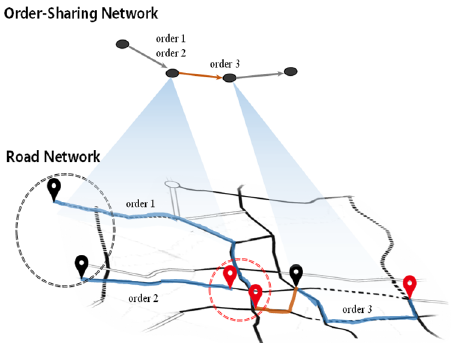
Figure 6. The sharing graph is a coarse-grained representation of taxi travel network with the order trajectory corresponding to a node in the upper-level